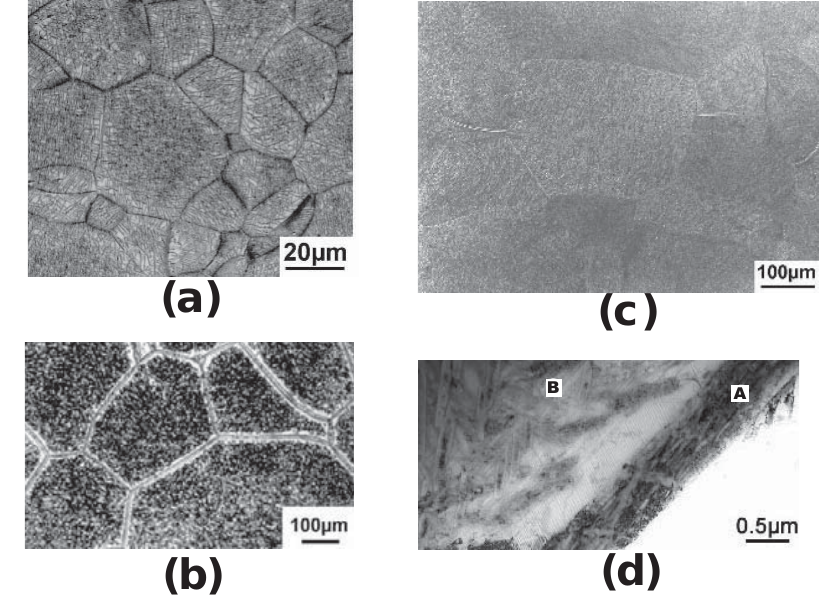
Figure 1. Continuous α layer at grain boundaries in some β titanium alloys: ( a ) β 21S; ( b ) Ti-10V-2Fe-3Al; and ( c ) Ti-5Al-5V-5Mo-3Cr (Ti-5553); ( d ) TEM photograph of continuous α layer (A) and matrix α plate structure (B) in Ti-5553 corresponding to ( c ) (from [1], by permission of c (cid:13) Springer Science + Business